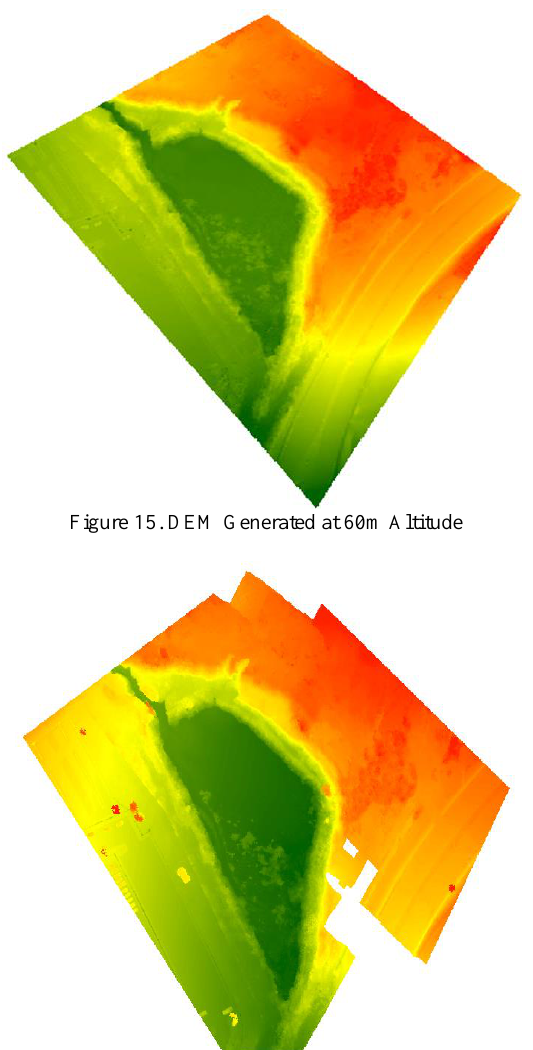
Figure 16. DEM Generated at 40m